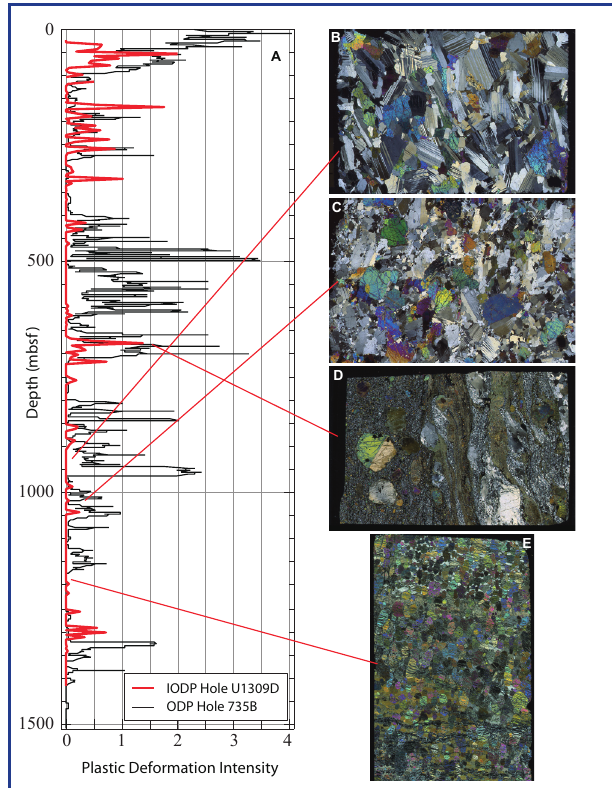
Figure 3. Intensity of crystal-plastic deformation and microstructural characters of magmatic and plastic foliations (cross-polarized light, field of view ~2 cm). [A] Compared deformation intensities (5 m running average) in ODP Hole 735B and IODP Hole U1309D (Crystal-plastic deformation scale : 0 = undeformed, 1 = weakly foliated, 2 = strongly foliated, 4 porphyroclastic). [B] Magmatic foliation. [C] High-temperature, low-stress, crystal-plastic foliation. Note the dynamic recrystallization of plagioclase and olivine. Crystal-plastic strain probably overprints a pre-existing magmatic foliation. [D] Mylonitic foliation (low temperature, high stress) with relict plagioclase and clinopyroxene porphyroclasts. [E] Olivine-rich troctolite with alignment, possibly magmatic, of weakly elongated olivines. Note that poikilitic plagioclase and clinopyroxene grains are not elongated parallel to